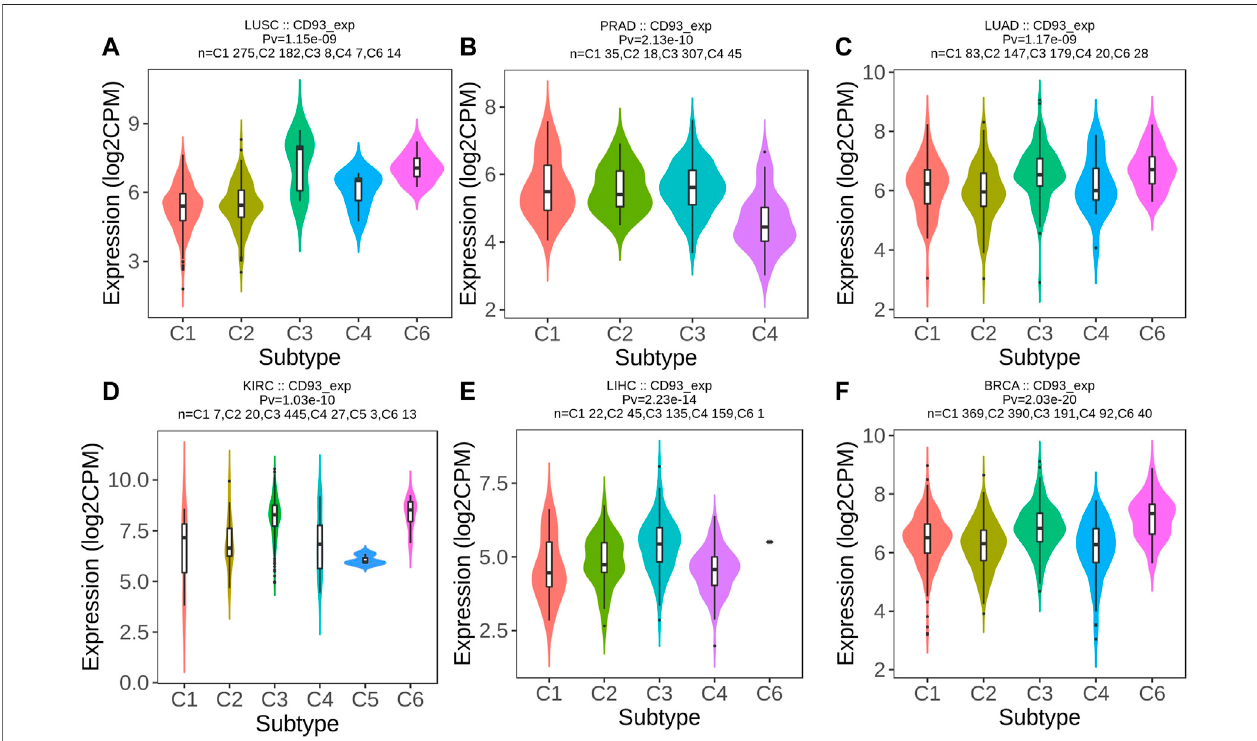
FIGURE 6 | CD93 expression and immune subtypes according to the Tumor – Immune System Interactions and Drug Bank (TISIDB) database. (A – F) Expression level of CD93 among different immune subtypes in six cancer types (LUSC, PRAD, LUAD, KIRC, LIHC, and BRCA).